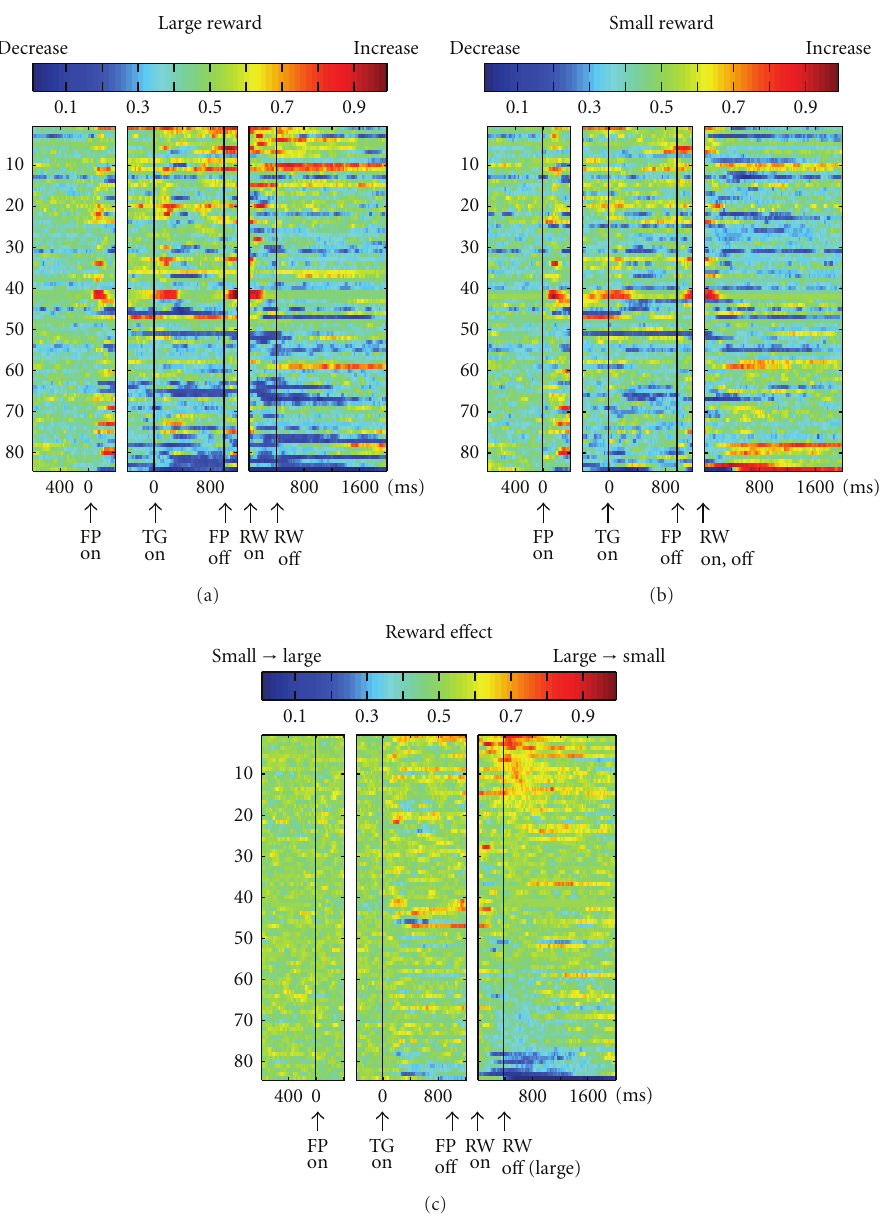
Figure 7: Population activity of DRN neurons. The activity of each neuron is presented as a row of pixels ( n = 84). (a, b) Changes in the neuronal firing rate from baseline are compared in the large- (a) and small- (b) reward trials. The color of each pixel indicates the ROC value based on the comparison of the firing rate between a control period just before fixation onset (400-ms duration) and a test window centered on the pixel (100-ms duration). Warm colors (ROC > 0.5) indicate increases in the firing rate relative to the control period, whereas cool colors (ROC < 0.5) indicate decreases in the firing rate. (c) Changes in reward-dependent modulation. The ROC value of each pixel was based on the comparison of the firing rate between the large- and small-reward trials. Warm colors (ROC > 0.5) indicate higher firing rates during the large-reward trials than during the small ones. In all panels (a–c), the neurons have been sorted in order of their ROC values for the reward e ff ect during the postreward (400–800ms) period (c). FPon: fixation point onset, TGon: target onset, FPo ff : fixation point o ff set, RWon and o ff : reward onset and o ff set. (Modified from